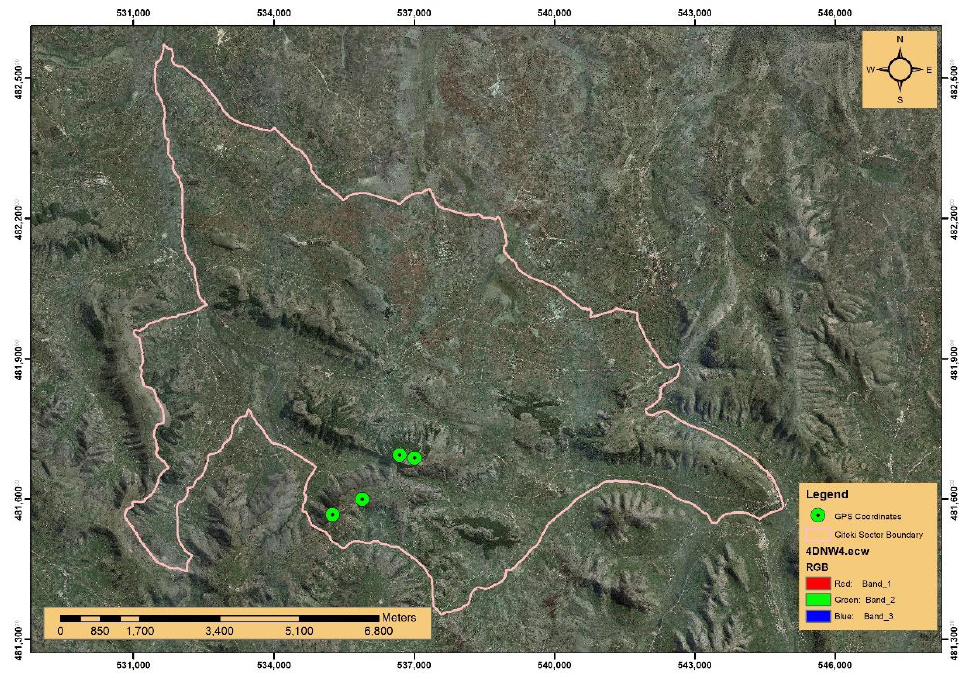
Figure 3. GIS map of the studied